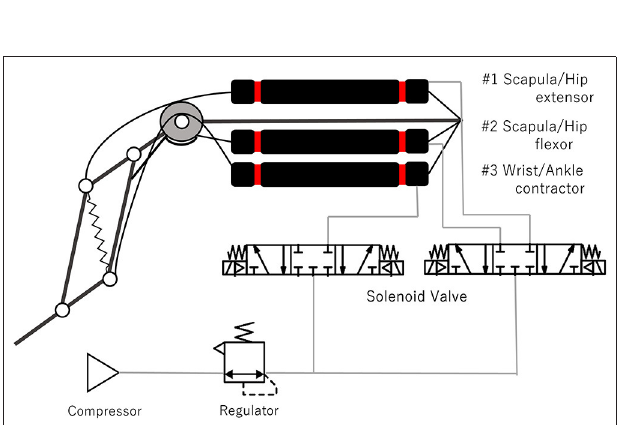
FIGURE 3 | Pneumatic actuators and pneumatic system for driving one leg.